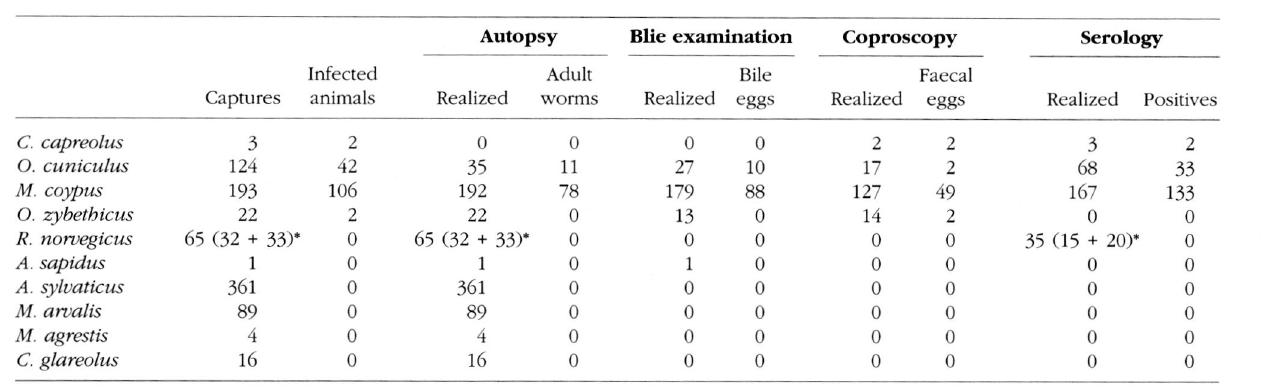
Table I. - Number of infected animals depending on the species and the screening method.